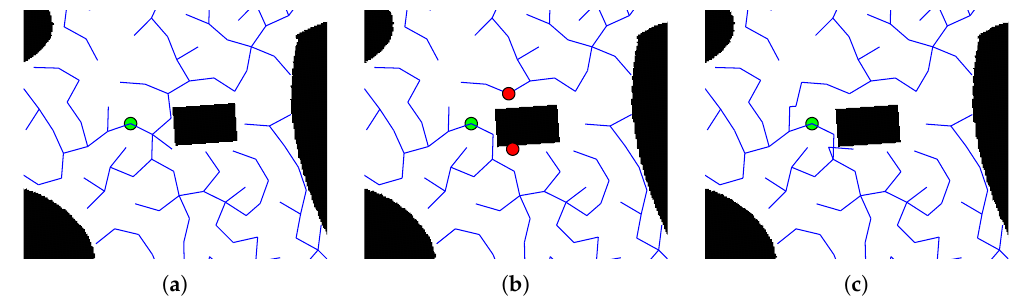
Figure 14. The branch-pruning and reconnection process. ( a ) The tree before obstacle moving. ( b ) The three sub-trees after the obstacle moving. ( c ) The tree after reconnection.